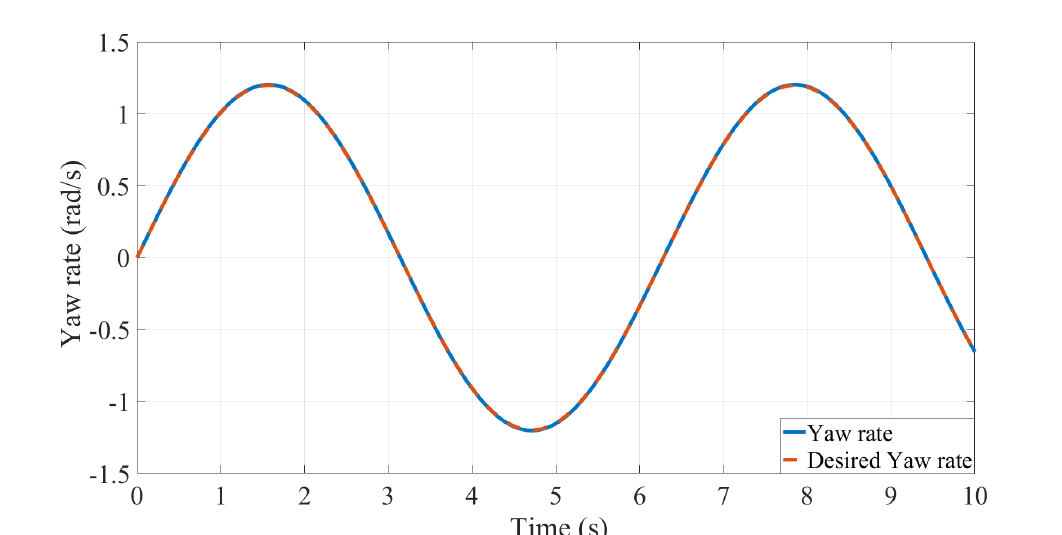
Figure 8. Controlled yaw rates with no disturbance with sine wave input.